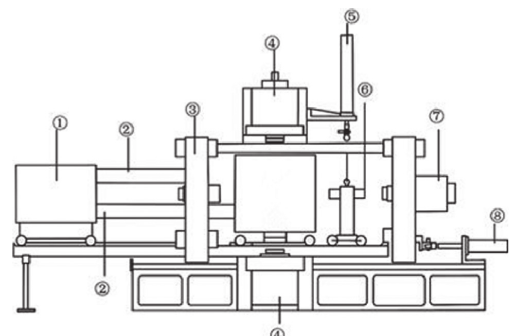
Figure 2: Setup diagram of artificially frozen soil true triaxial testing machine. (1) Temperature control cabinet. (2) Inlet air duct, return air duct. (3) Floating loading frame in y direction. (4) Z direction loading cylinder. (5) Lifting device for extension rod in y direction. (6) Lengthening device in y direction. (7) Load cylinder in y direction. (8) Loading frame pulling device in y